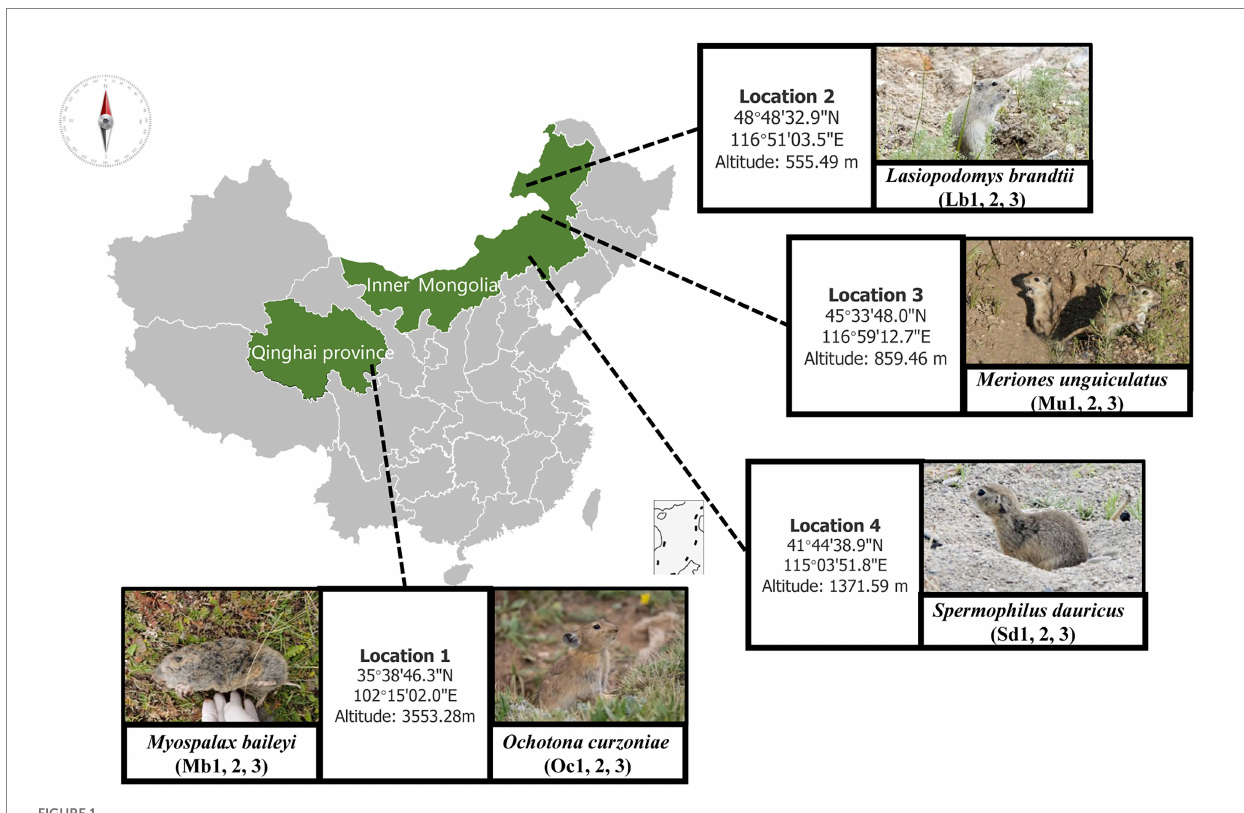
FIGURE 1 Sampling sites and host animal species names.